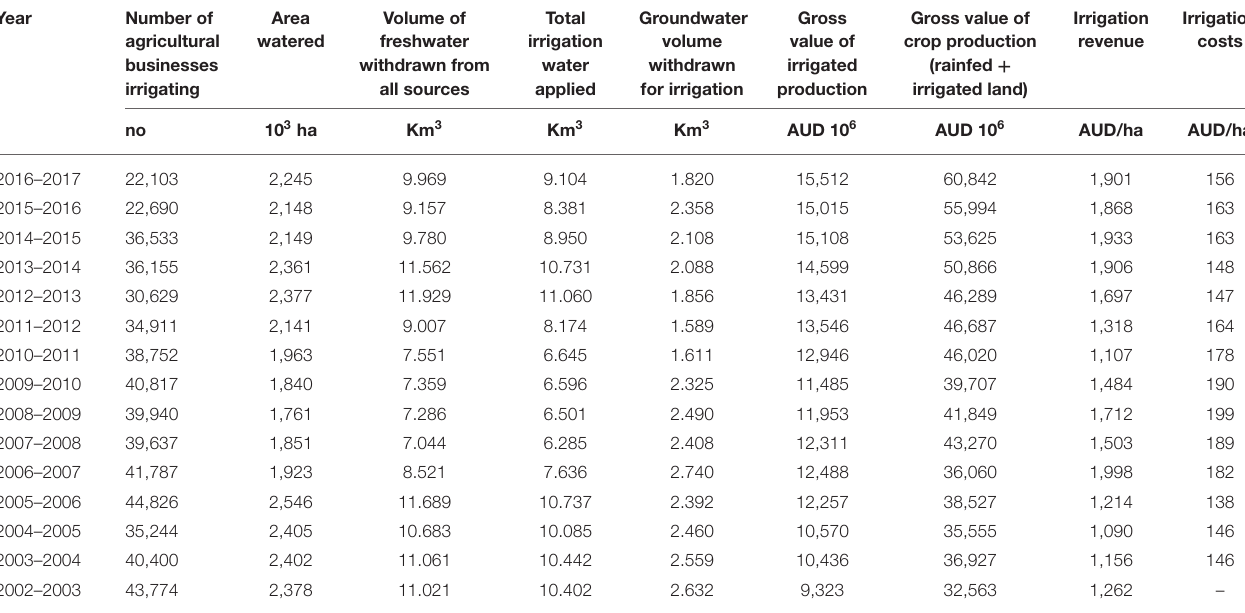
TABLE 3 | Environmental and socio-economic indicators of irrigation in Australia, based on the ABS